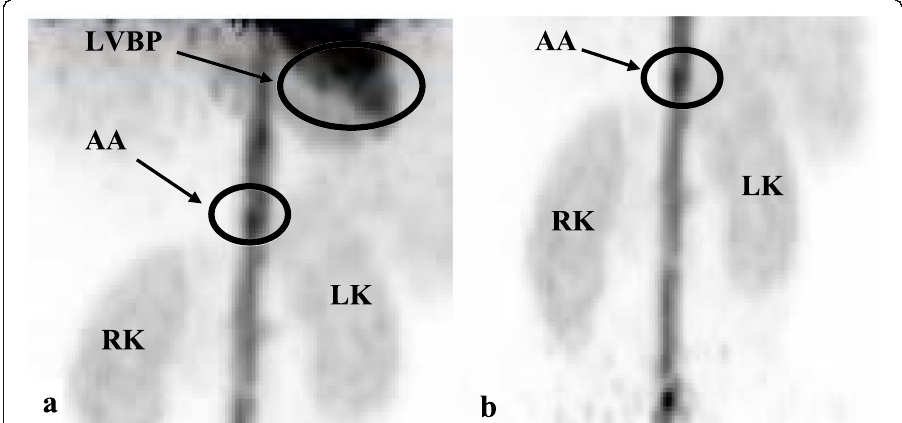
Fig. 2 Anatomical contents within the 22-cm axial FOV for an example study image (subject 2): a FOV-A: bed position includes LVBP, AA and kidneys (body length and kidney size determine whether the kidneys can be seen in their entirety within the FOV); b FOV-B bed position includes AA and kidneys